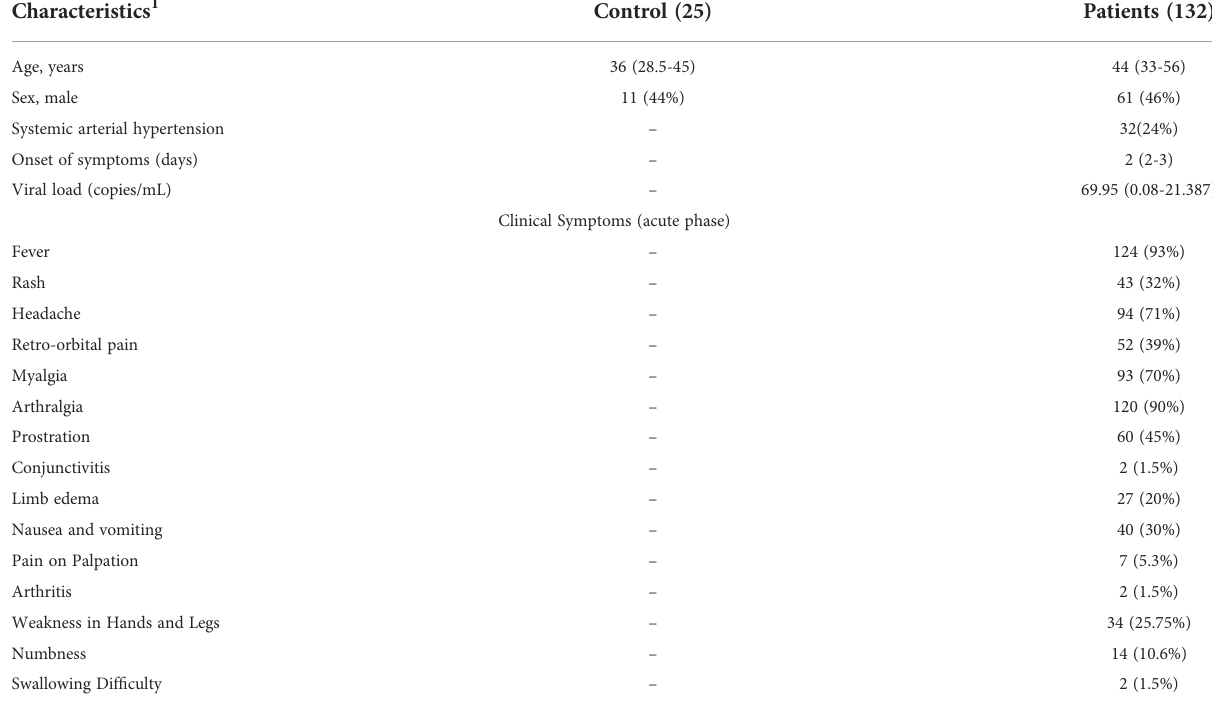
TABLE 1 Characteristics of Chikungunya patients and control